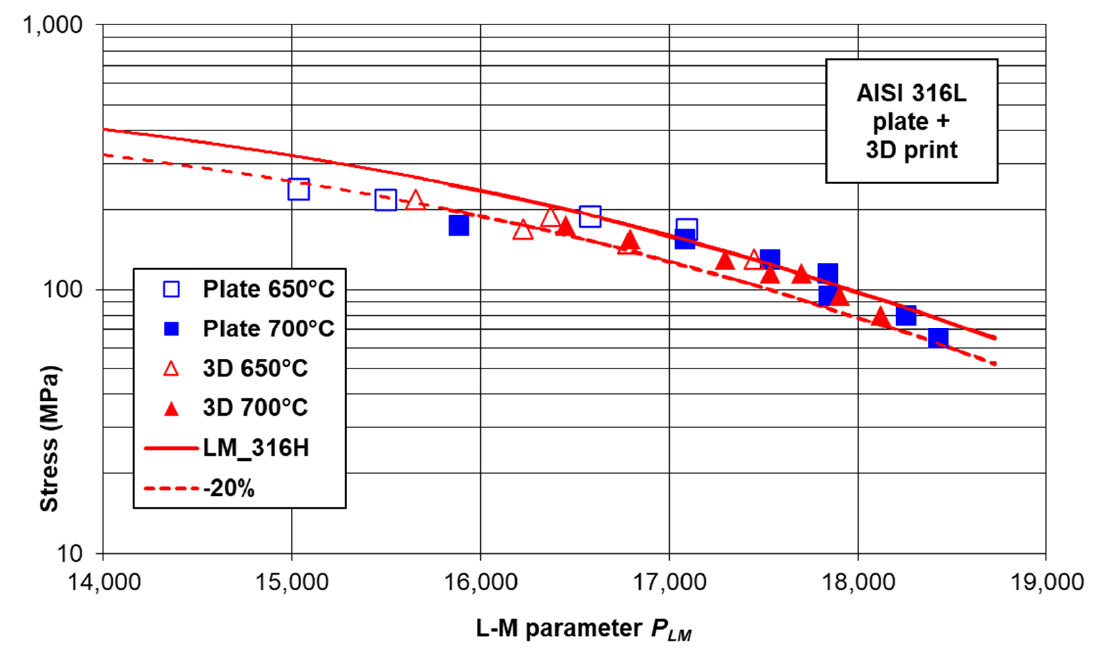
Figure 7. Comparison of the results of stress rupture tests of the 3D-printed block and hot-rolled AISI 316L steel plate with the mean value and − 20% tolerance limit of creep rupture stress (CRS) for AISI 316H steel.